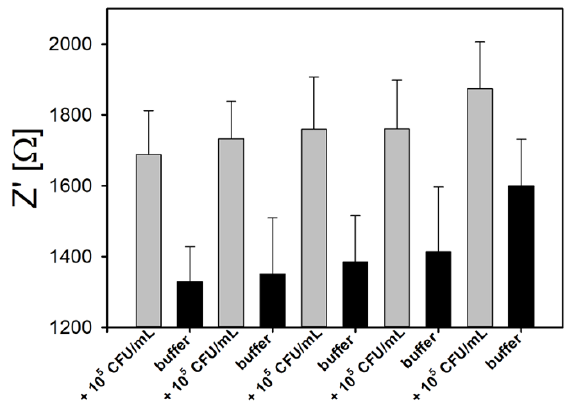
Figure 5. Reusability of 47-mer aptasensor after washing with NaOH at 25 °C (pH = 9.4) and rinsed in PBS (pH = 7.1). The average hysteresis after NaOH washing was 2.1 ± 2.0% for up to three reuse cycles, and 15.6 ± 6.5% after five reuse cycles. Error bars represent standard deviation of the arithmetic mean.